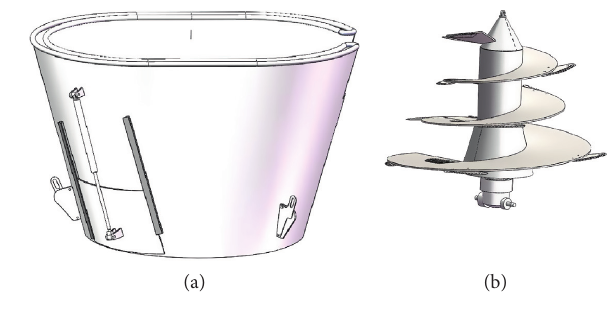
Figure 6: Mixing device: (a) bin; (b) auger.